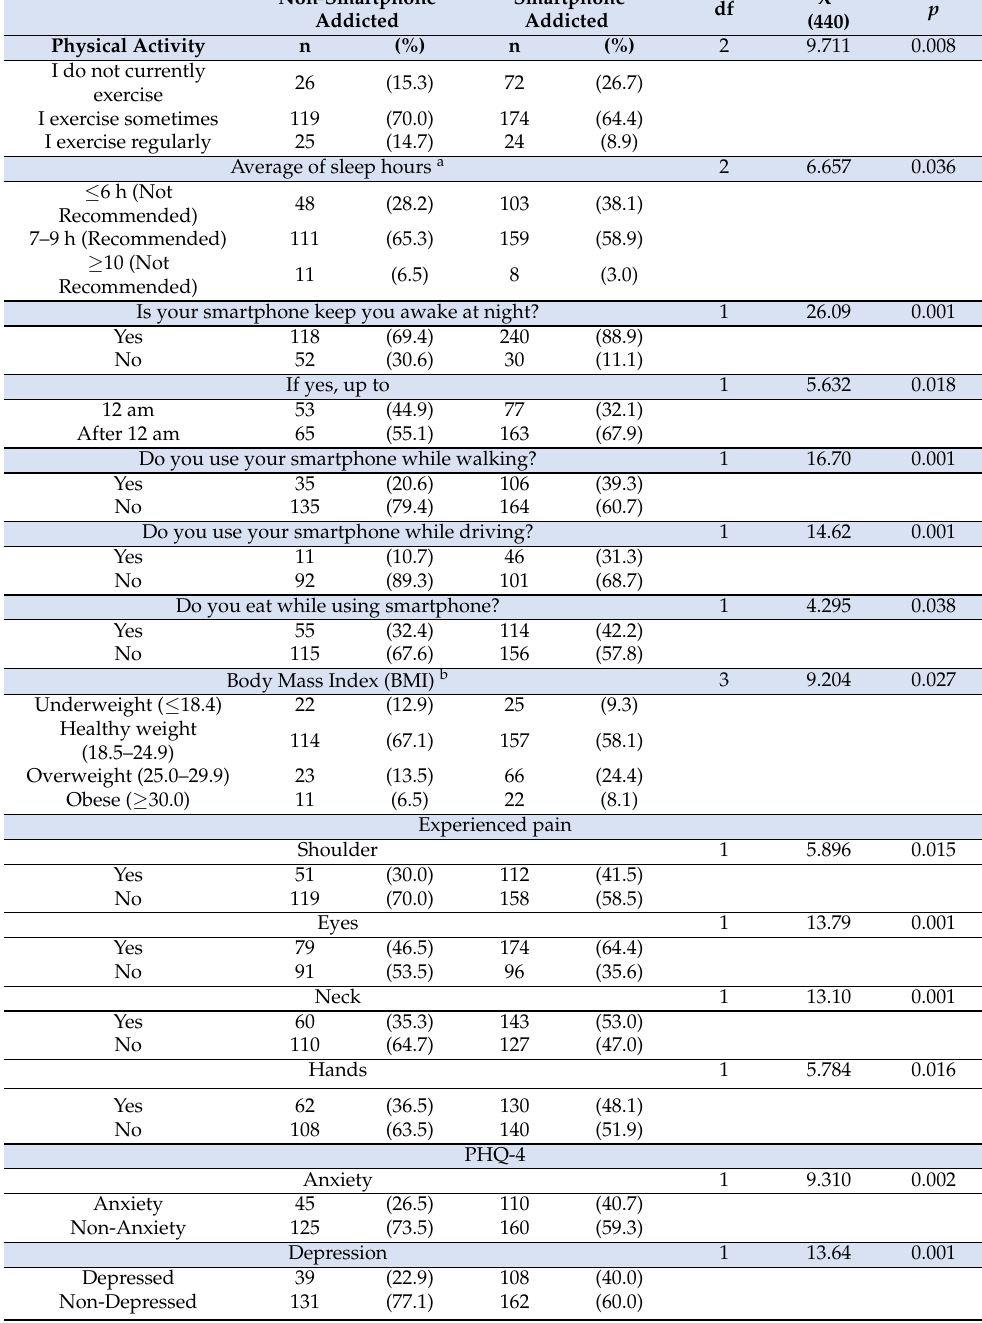
Comparison between physical health and mental well-being information between smartphone-addicted and non-smartphone-addicted groups, N =